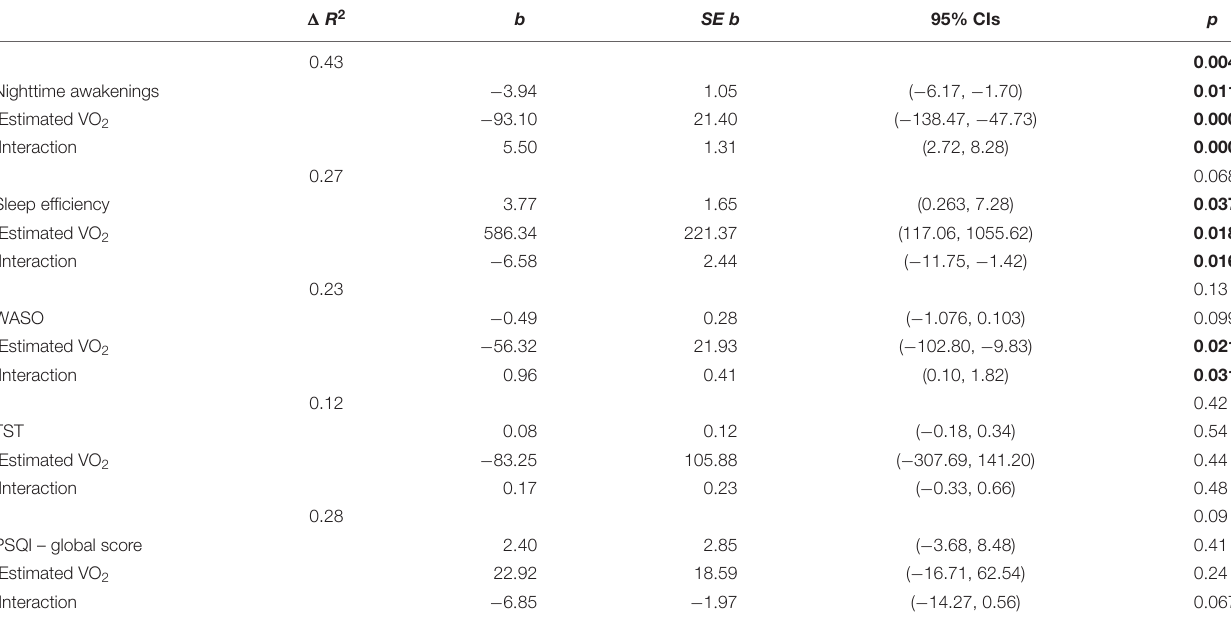
TABLE 2 | Regression coefficients of the moderating effect of cardiorespiratory fitness and sleep on high-interference memory, in older